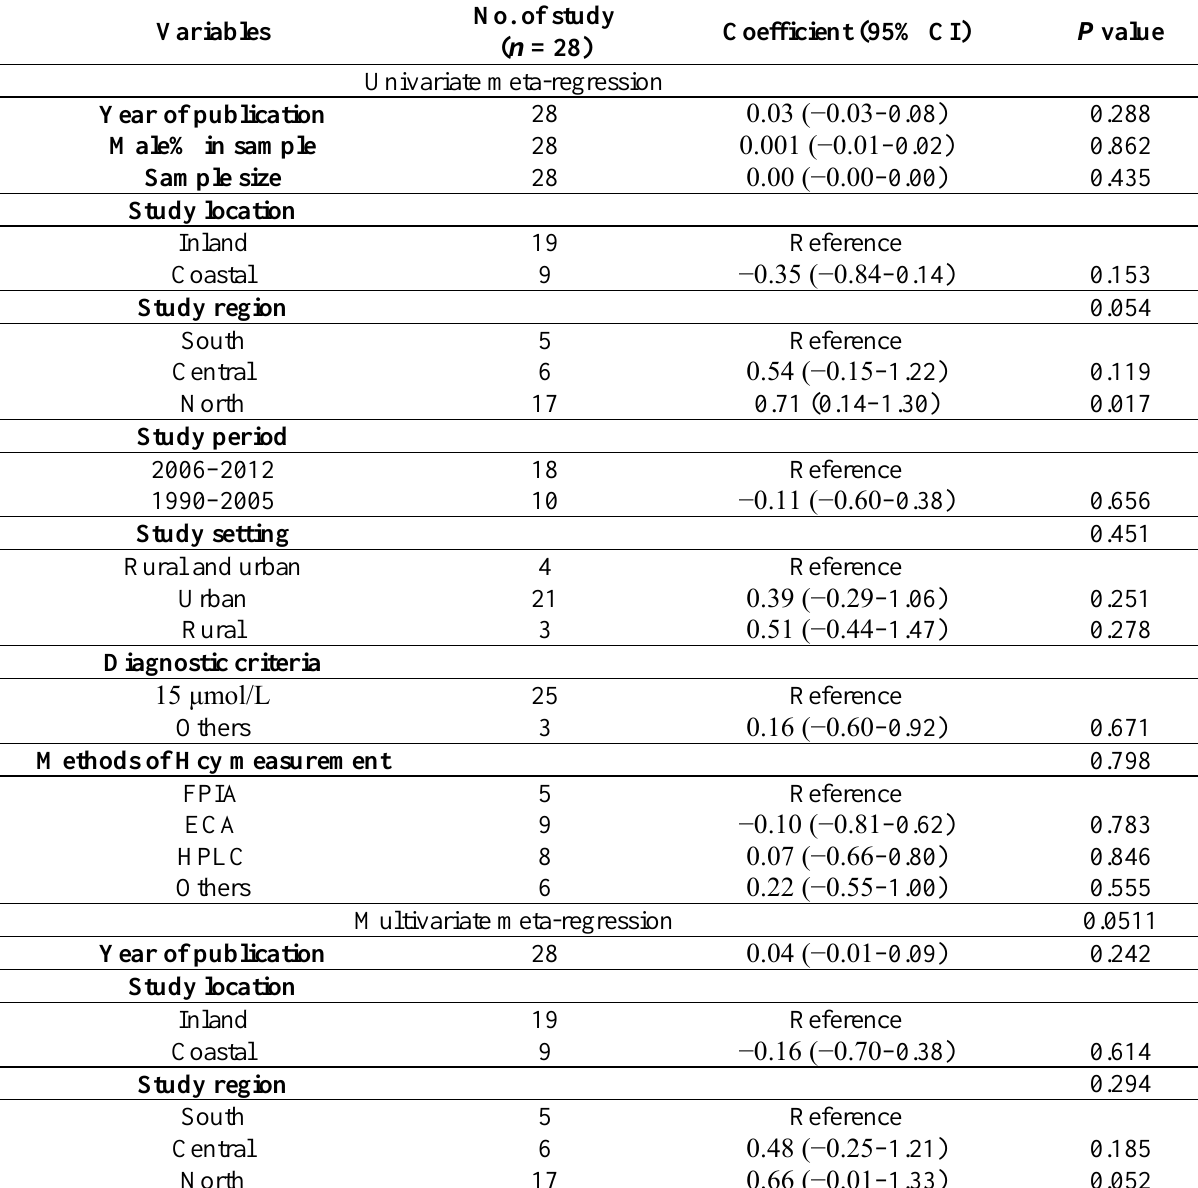
Table 3. Univariate and multivariate meta-regression for prevalence of